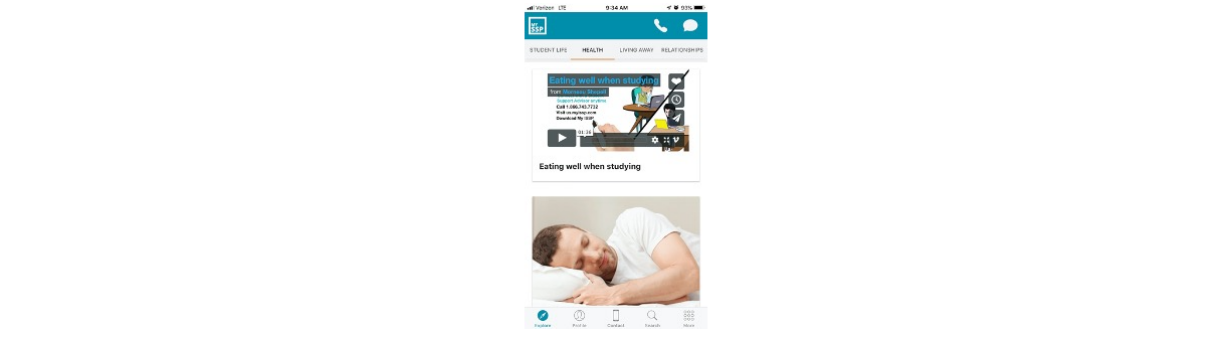
Figure 2. Health screen of the MySSP app.